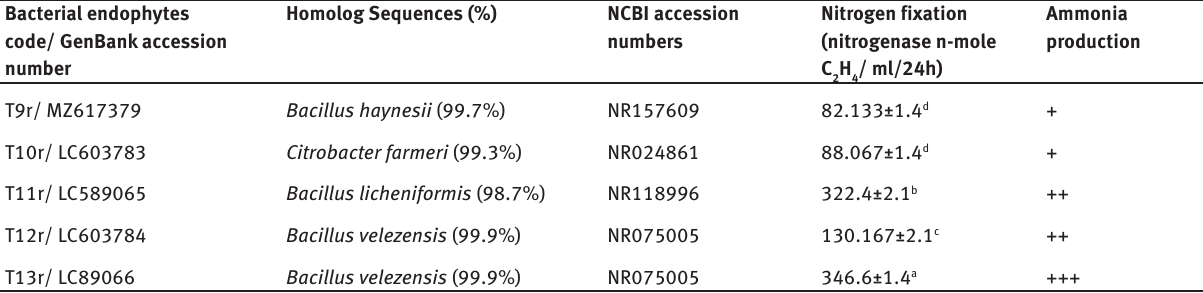
Table 3: Molecular identification based on 16S rRNA sequencing of the most potent bacterial endophytes isolated from T. vulgaris L., and the quantitative evaluation of their nitrogen fixation and phosphate solubilization